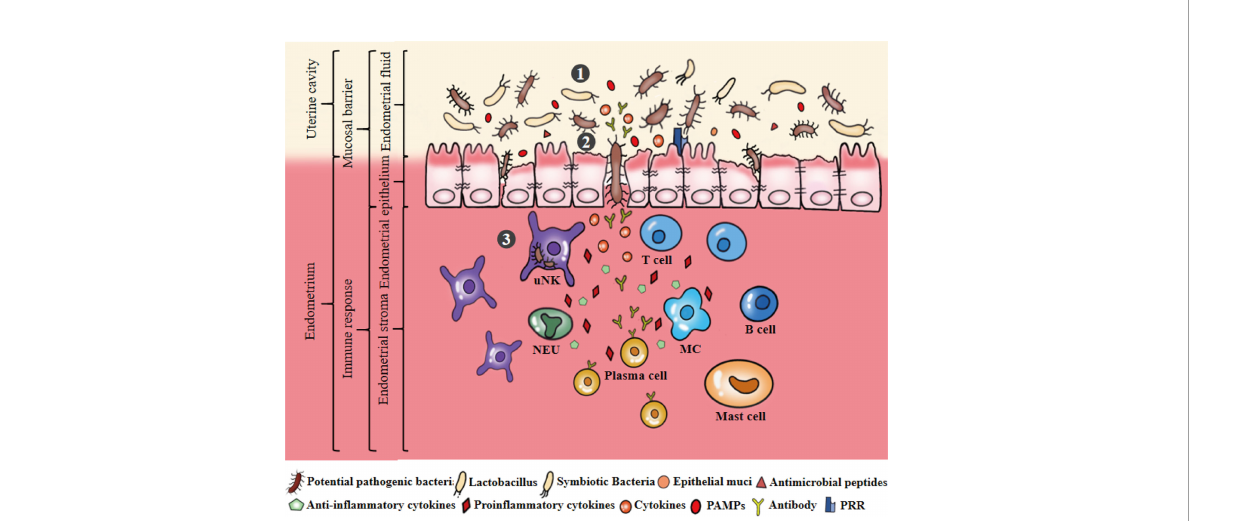
FIGURE 4 Microecological disorders of the uterus. ① The ecological imbalance of endometrial microbiota, such as the decrease of symbiotic bacteria, the increase of pathogenic bacteria. Dysregulation of bacterial metabolites, such as the abundance of PAMPs signi fi cantly greater than AMPs and mucins secretion. ② Microecological imbalance promotes pathogenic bacteria to invade, colonize and multiply on the endometrium by destroying the endometrial epithelial barrier. ③ Pathogenic bacteria stimulates epithelial cells to produce a large number of in fl ammatory cytokines that can stimulate, recruit and aggregate immunoactive cells to produce cytokines, antibodies and other substances to eliminate and resist pathogenic bacteria. Secretion of pro-in fl ammatory cytokines can promote the development of endometrial in fl